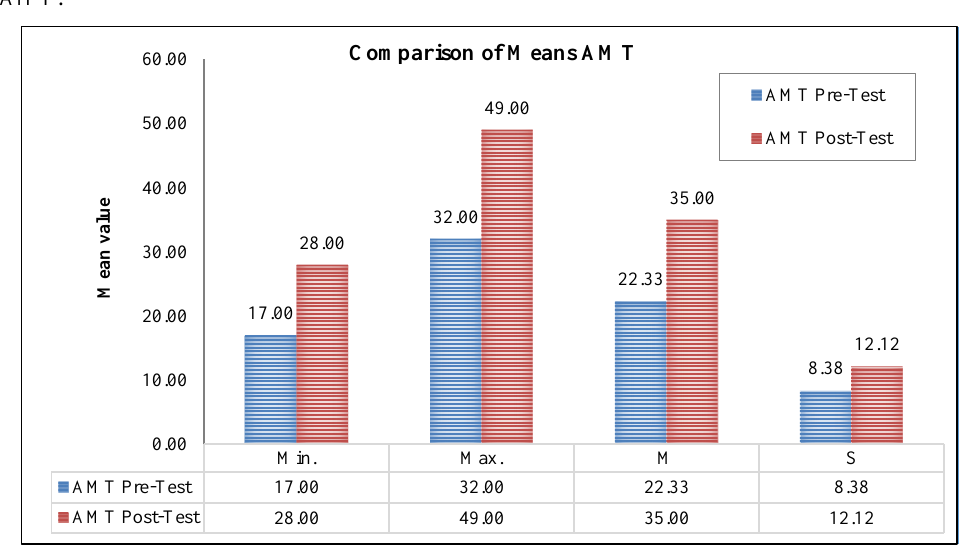
Figure 1. Statistical comparison between the pre- and post-test of the Autobiographical Memory